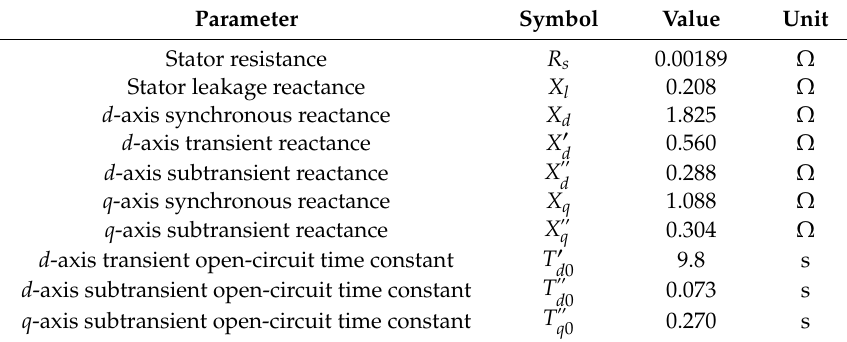
Table A2. Synchronous generator